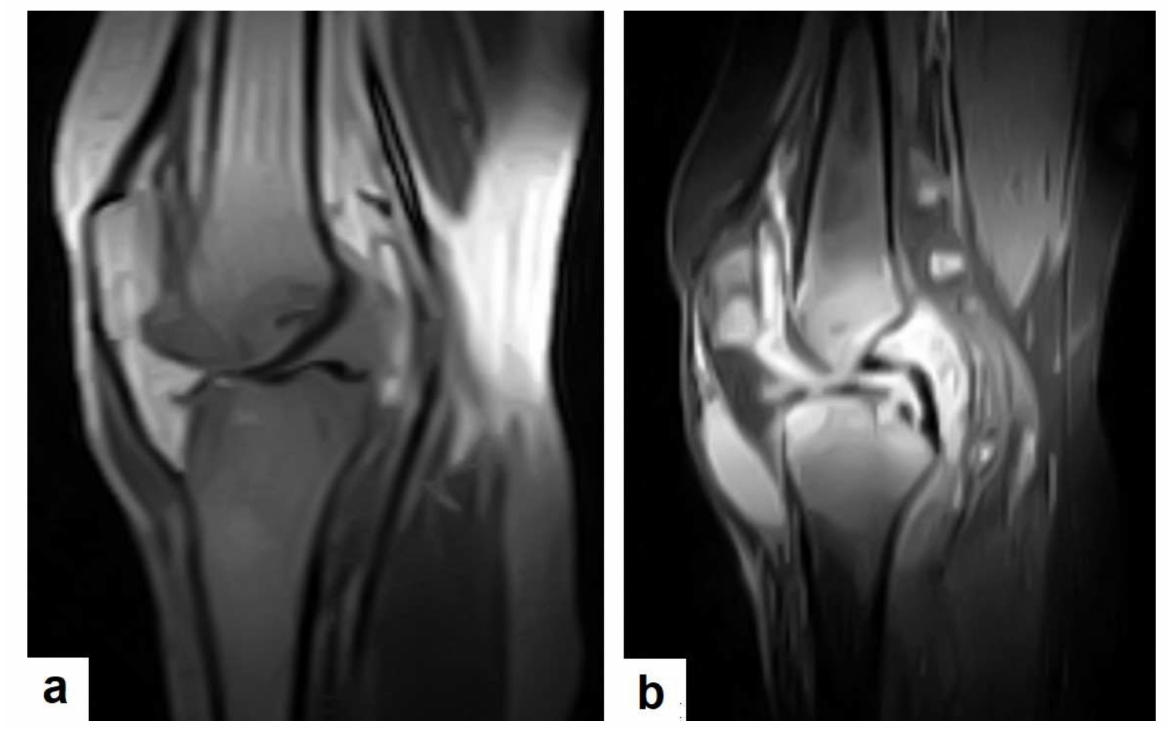
Figure 24. Knee TB in a 45-year-old patient with proved case of knee TB infection. Selected sagittal MRI images of ( a ) T1-weighted image and ( b ) T2-weighted image show extensive oedema of the articular surfaces of the knee, appearing as low signal intensity on T1 and high signal intensity on T2 with diffuse synovial thickening and large bone erosions (arrow heads), with mild joint effusion and a prepatellar pocket of fluid collection, which appear as low signal intensity on T1 and high signal intensity on T2. In addition, multiple enlarged popliteal lymph nodes were